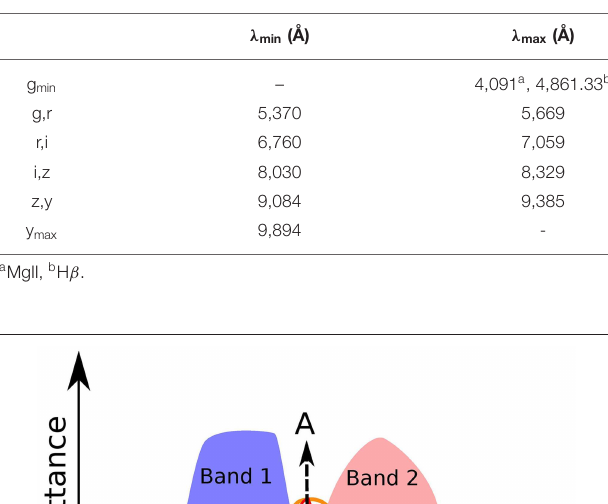
0.2 on the lower wavelength side of the = 0 is inclusive =